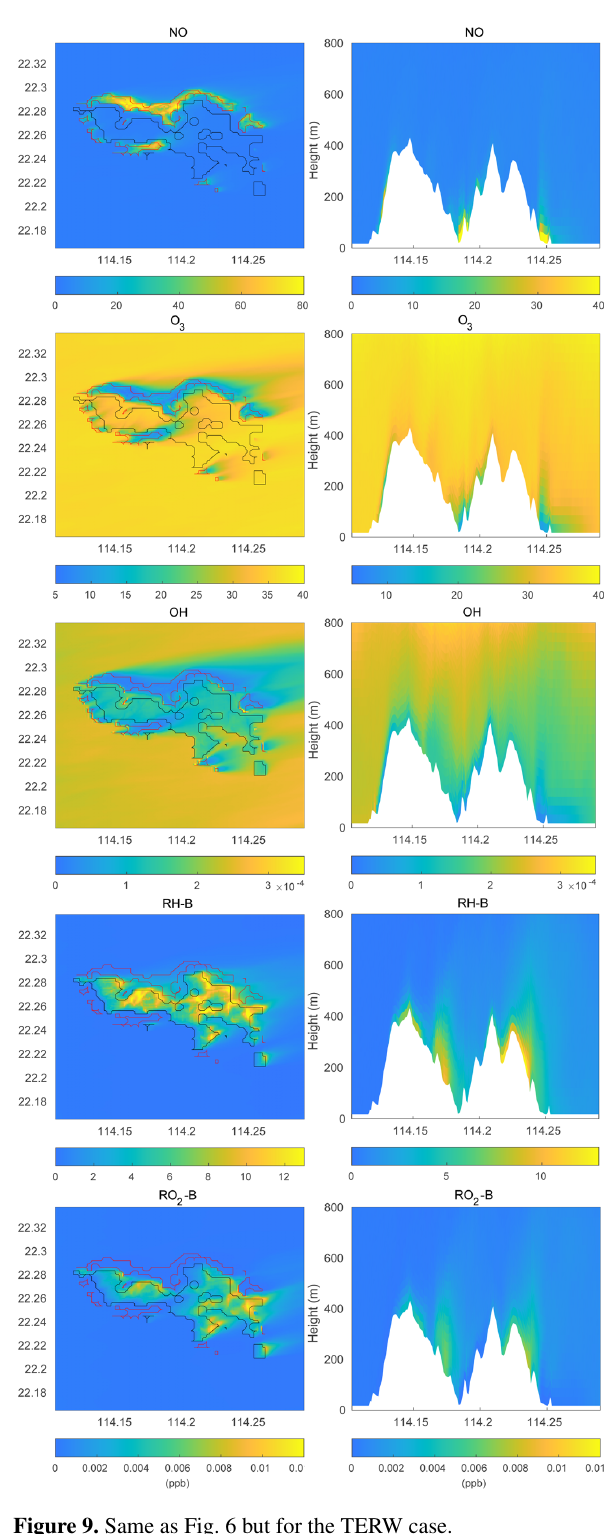
Figure 9. Same as Fig. 6 but for the TERW